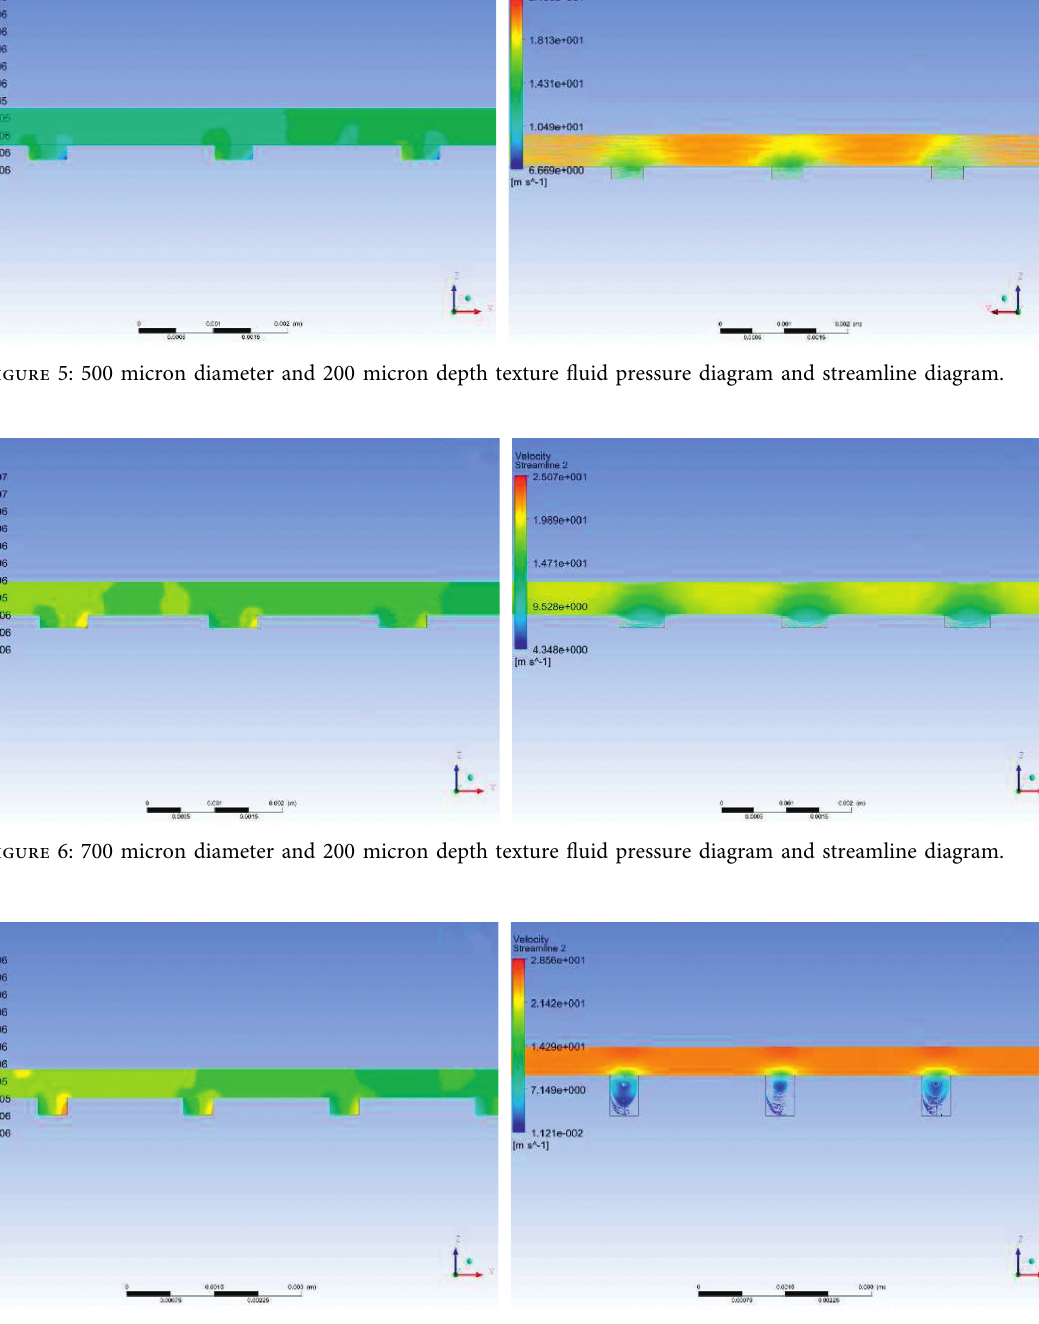
Figure 7: 500 micron diameter and 300 micron depth texture fluid pressure diagram and streamline